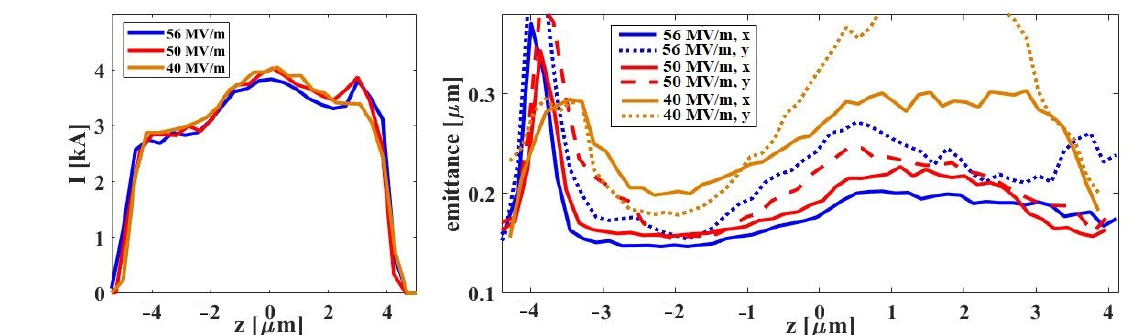
Figure 7. Current profiles ( left ) and slice emittance ( right ) along the bunches at the entrance of SA1 undulators using multiple peak accelerating gradients at the